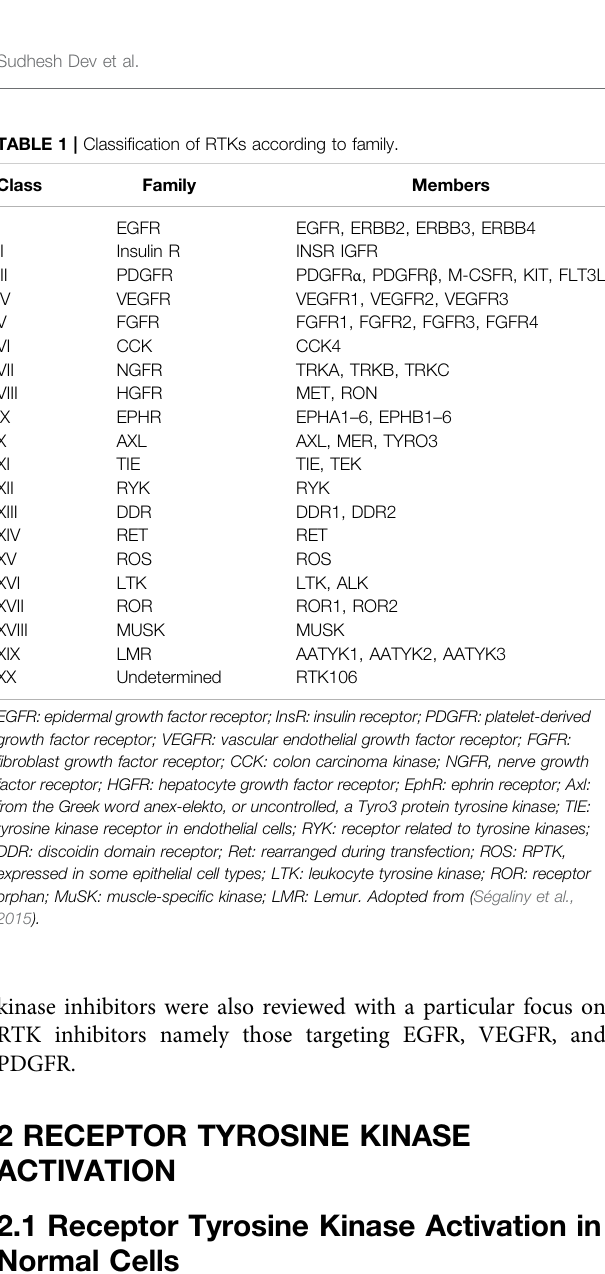
TABLE 1 | Classi fi cation of RTKs according to family.